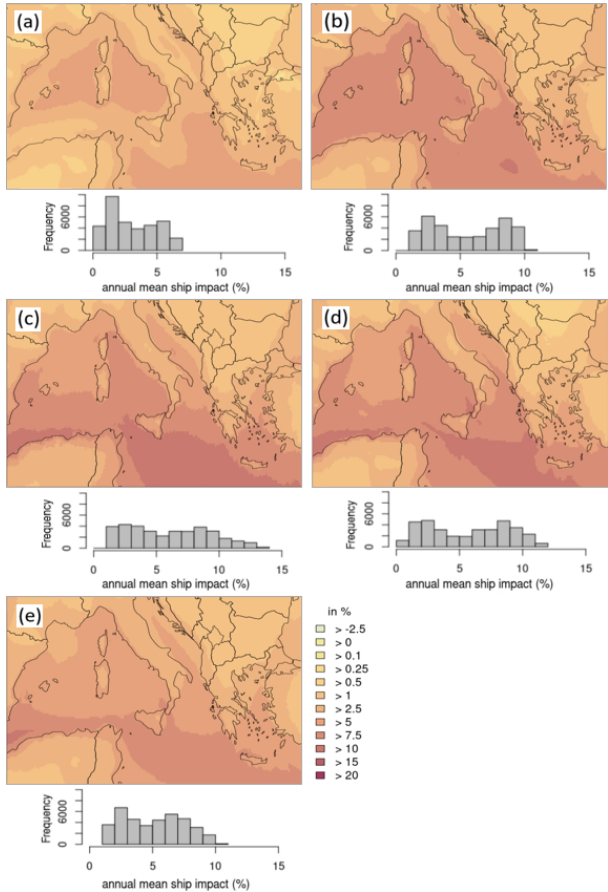
Figure 11. Annual mean O x ( = NO 2 + O 3 ) potential ship impact. EUROS. Below the domain figure the respective frequency distri- bution is displayed for the annual mean O x potential ship impact, referring to the whole model